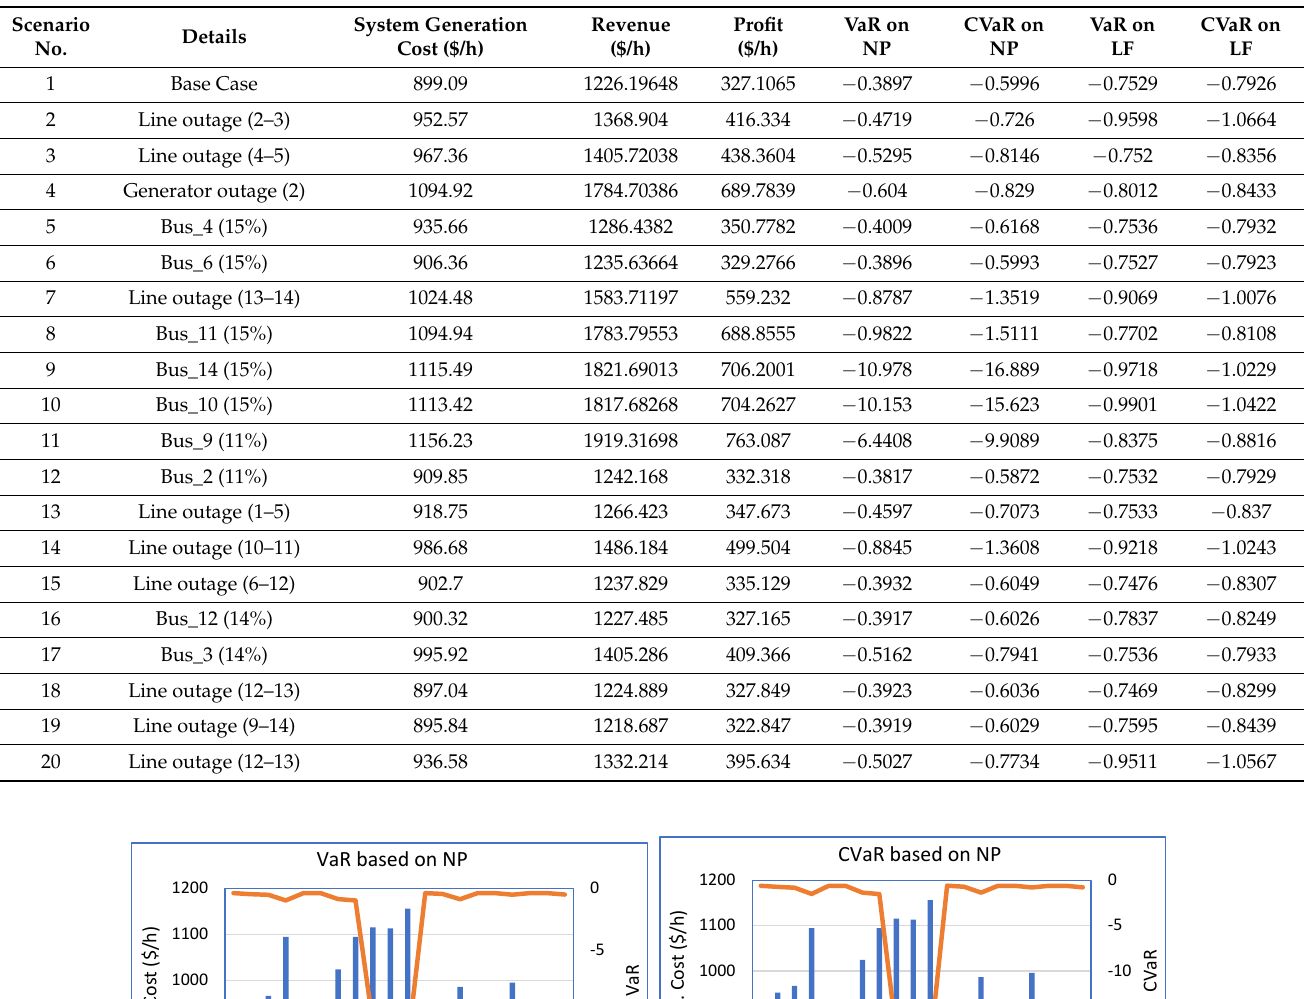
Table 1. Economic parameters and system risk of the system.